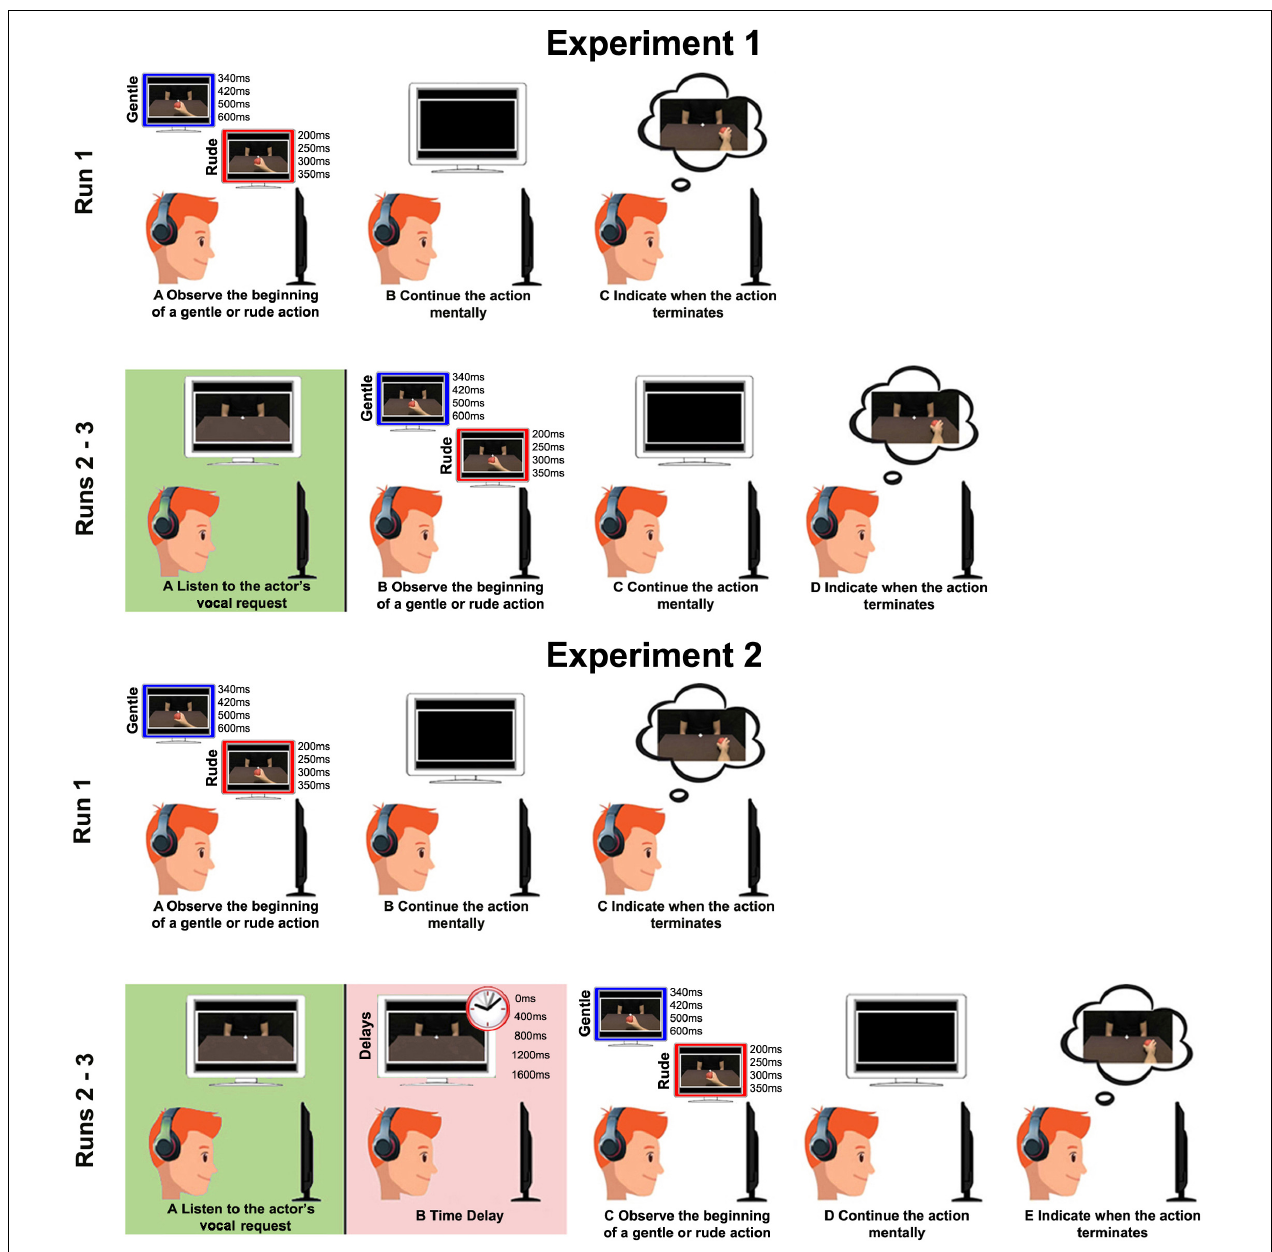
FIGURE 3 | For both the experiments, in Run 1: (A) participants observed the beginning of a gentle or rude action; (B) continued the action mentally; and (C) indicated the time of its end. For Experiment 1, in Run 2 and Run 3: (A) participants listened to a rude/gentle vocal request; (B) observed the beginning of the same gentle or rude action; (C) continued the action mentally; and (D) indicated the time of its end. In Experiment 2, Run 2 and Run 3 were the same and participants were required to perform the same task (E) , but one of four possible time delays was inserted between the vocal request and the video stimuli (400, 800, 1200, and 1600